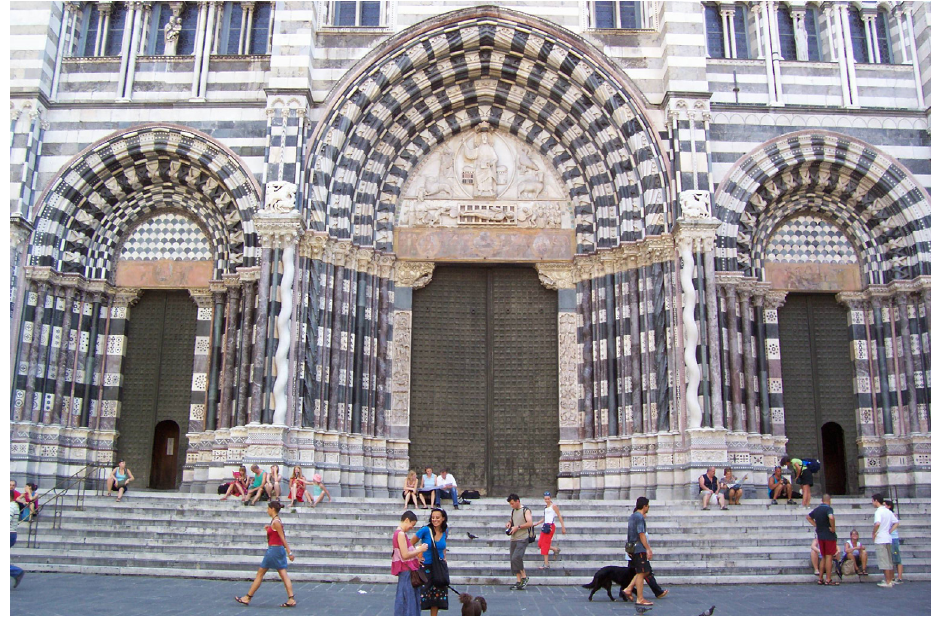
Figure 2. Façade of the cathedral in Genoa. It is composed of white marble, red limestone and green blocks of serpentinite. Picture courtesy of V. Sánchez Escribano.